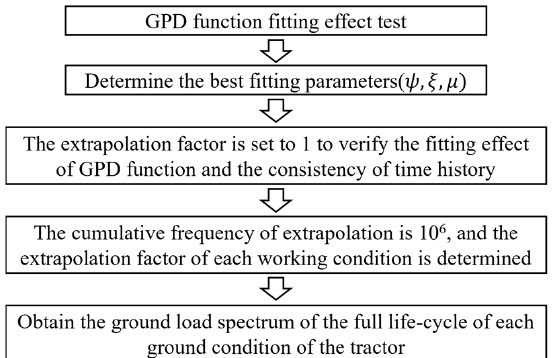
Figure 8. Ground load spectrum extrapolation flowchart.